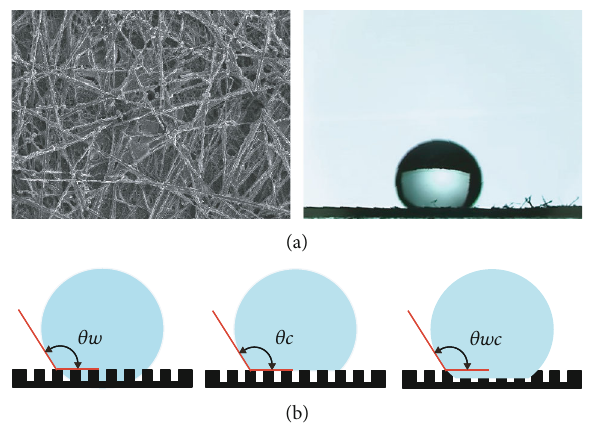
Figure 3: (a) The carbon paper and droplet and (b) di ff erent contact patterns of droplet on the GDL.